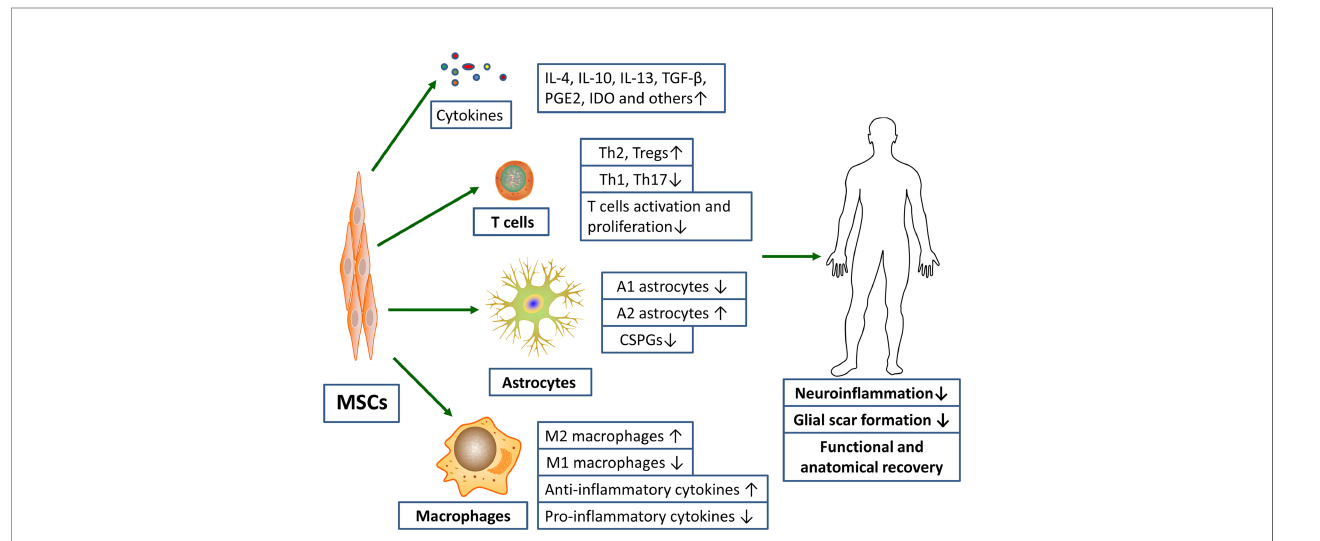
FIGURE 2 | MSCs transplantation promotes functional and anatomical recovery in SCI patients by inhibiting excessive in fl ammatory response and glial scar formation. Notes: ↑ , promotion; ↓ ,